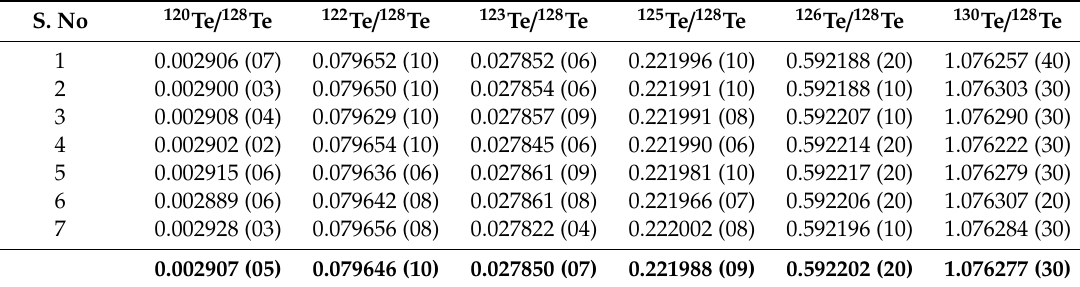
Table 1. Te isotope ratios of Kanto Chemical Reagent